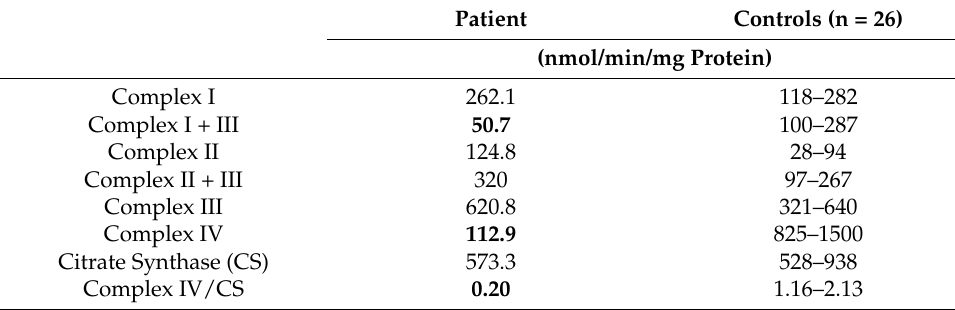
Table 1. Activities of respiratory chain complexes in muscle